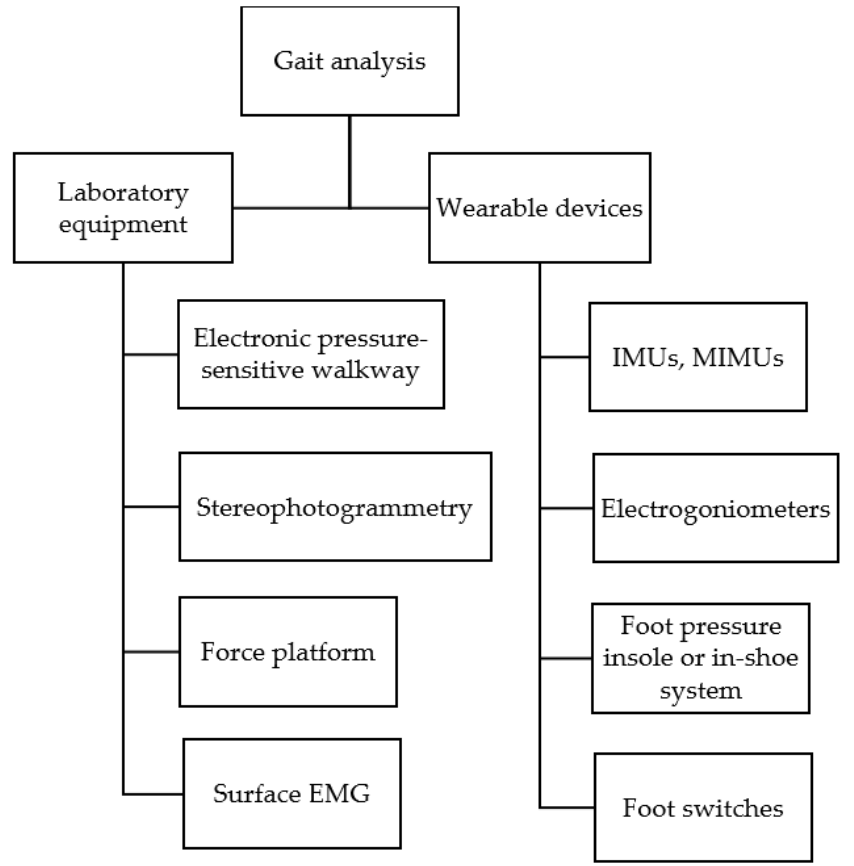
Figure 1. Diagram presenting the main techniques for gait analysis. One or more wearable devices can also be used in a laboratory